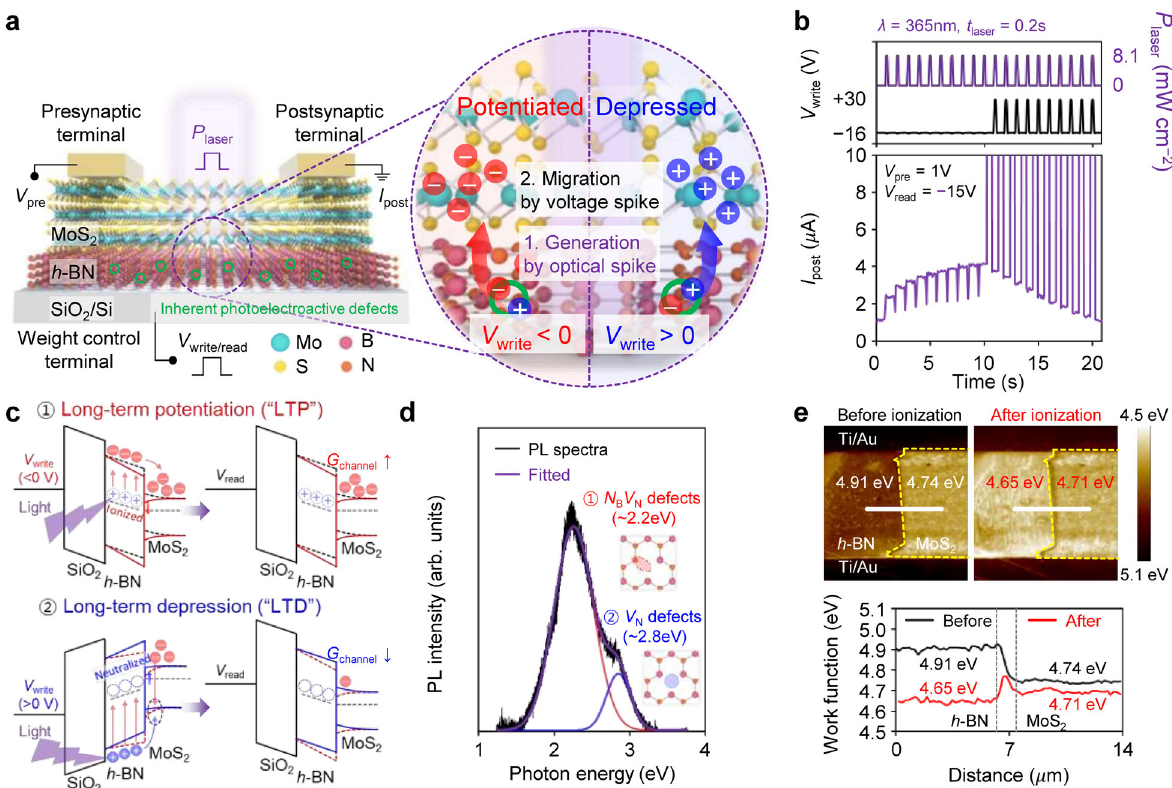
Fig. 1 Light and voltage co-stimulated synapse based on MoS 2 / h -BN heterostructure. a Schematic illustration of device structure and bidirectional weight operation process. b Postsynaptic current ( I post ) responses to the co-stimuli consisting of optical and electrical spikes. c Energy band diagrams indicating weight-updating principles of long-term potentiation and depression (LTP/D). d Photoluminescence (PL) spectra of h -BN. e Kelvin probe force microscope (KPFM) work function mapping image of h -BN and MoS 2 before and after ionization of h -BN